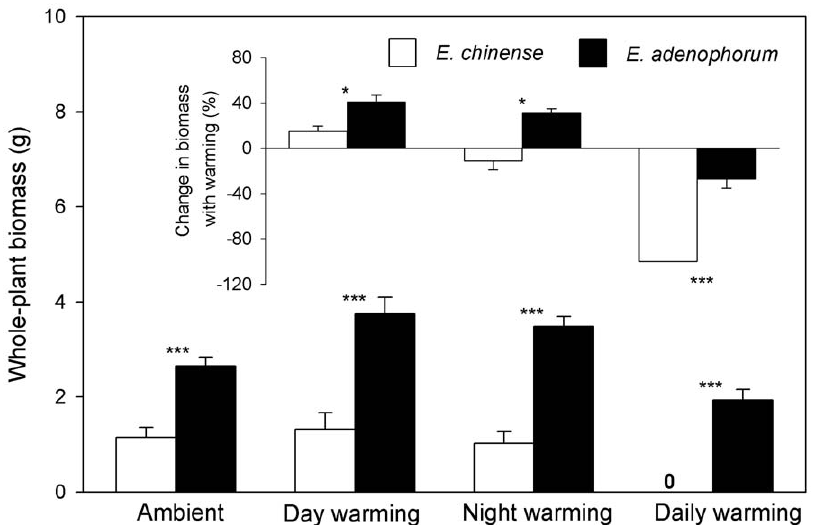
Figure 2. Whole-plant biomass of the invasive plant Eupatoriumadenophorum and the native plant Eupatoriumchinense grown in four different air temperatures, and changes in whole-plant biomass with warming for both species (embedded smaller panel inside). Data are means + 1 SE. * P , 0.05; *** P , 0.001.